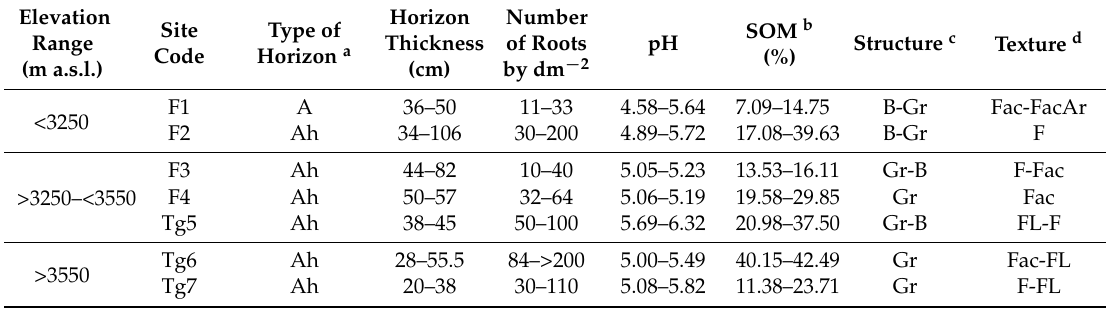
Table 3. Morphological characteristics of the superficial horizons of the soils in the natural undisturbed land cover areas (F = High montane forest; Tg = P á